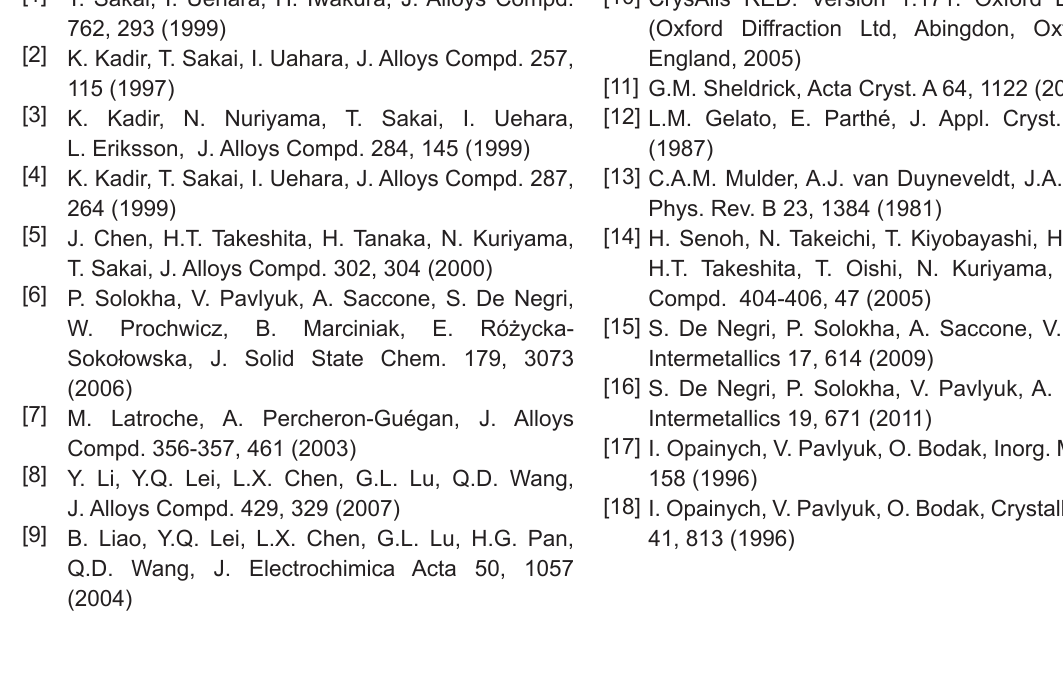
Ni , and LaMg 2 9